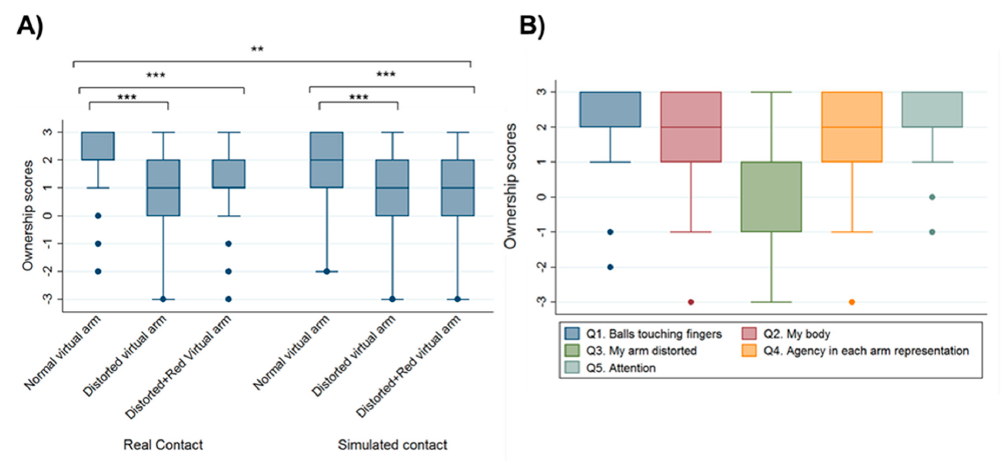
Figure 4. Ownership levels increase with the normal representation of the virtual arm. ( A ) Ownership question ratings after each virtual reality condition exposure show higher ownership scores in the normal virtual arm representation compared with the distorted and reddened ‐ distorted conditions, in both real and simulated contact of the threatening stimulus. ( B ) Questionnaire ratings after the whole virtual reality exposure show that although participants reported high levels of agency and ownership of the virtual body, ownership scores decreased with the distorted virtual arm representation. Boxplots show medians (horizontal lines), interquartile ranges (IQR; boxes), data outside 1.5 × IQR (whiskers), and outliers (o). ** p < 0.01, *** p < 0.001. Table 2. Scoring values in terms of mean, standard error (SE) and p ‐ values for all the different experimental conditions.